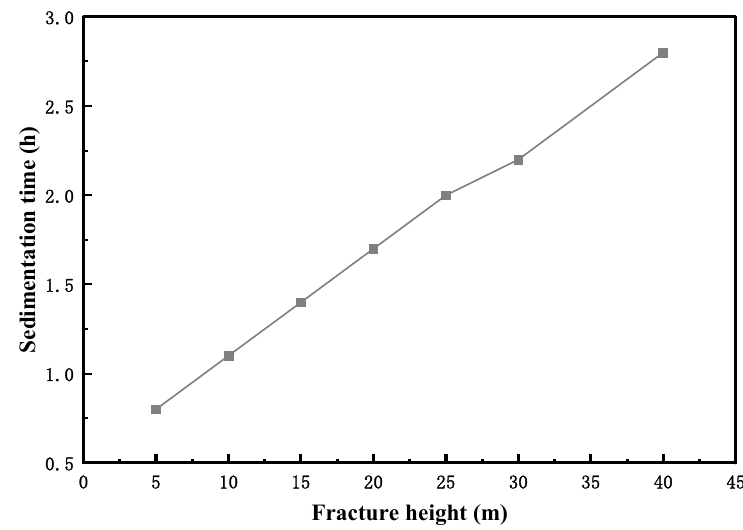
Figure 18. Settlement time at different fracture heights.